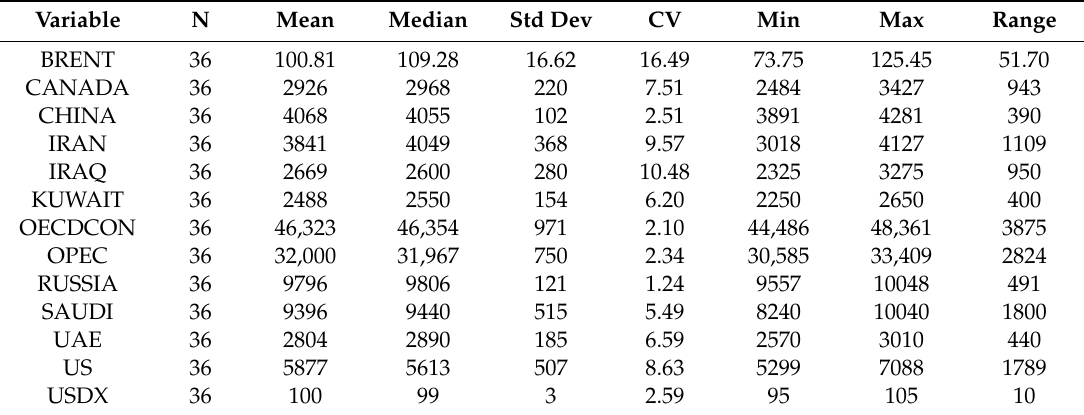
Table 13. Panel 5 period (2010–2012): summary statistics.